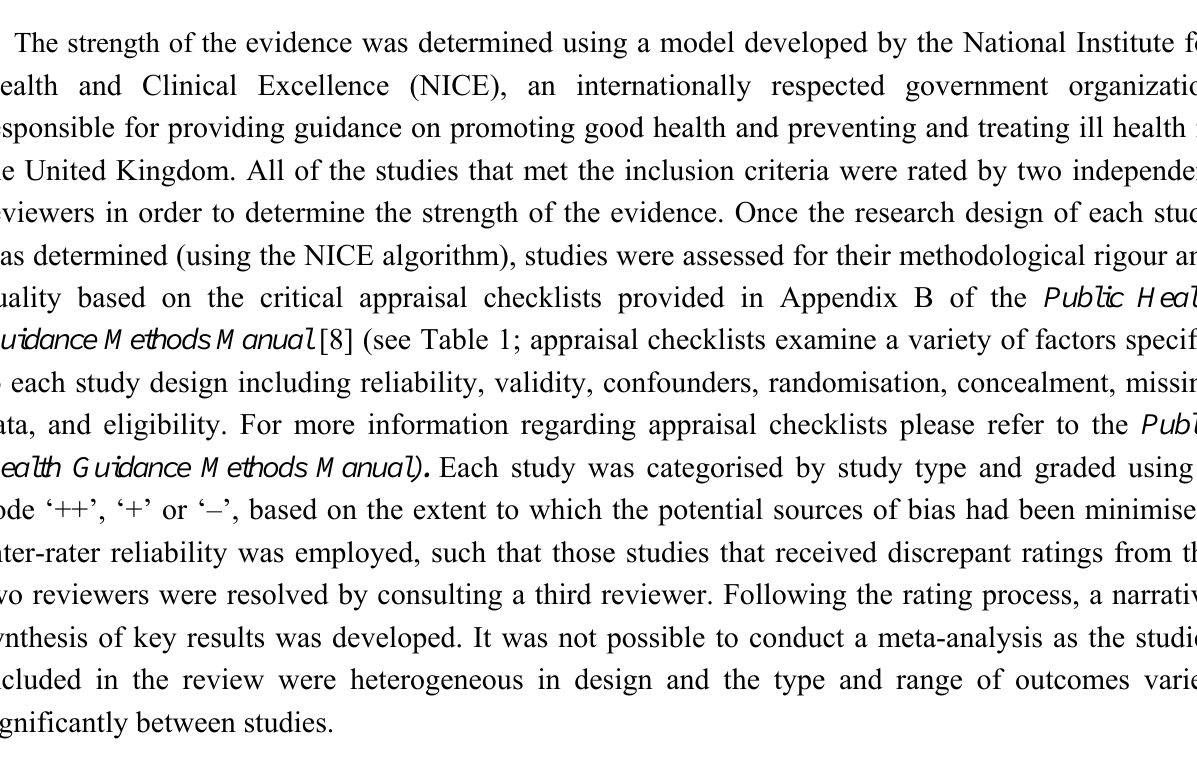
Table 1. Type and quality of